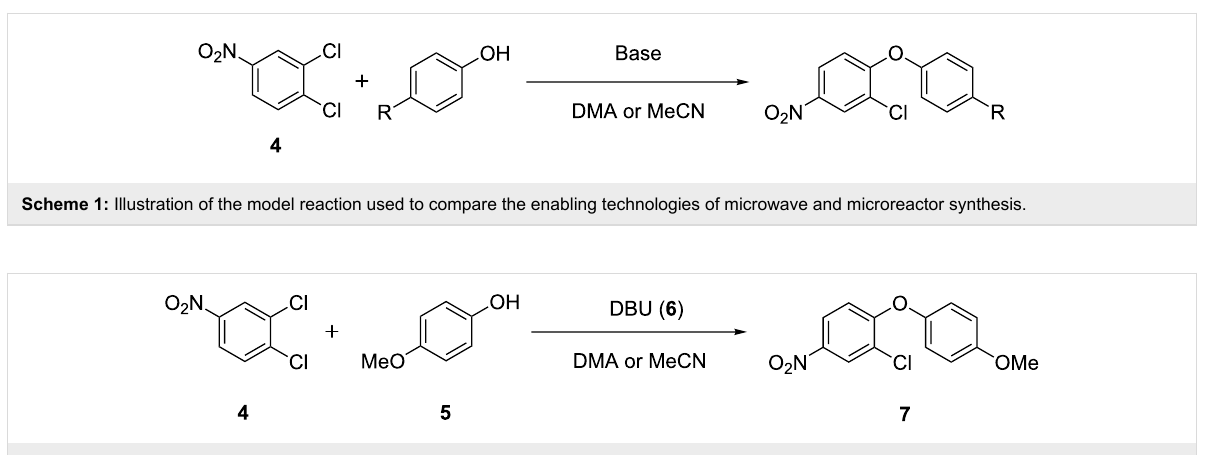
Scheme 2: Illustration of the model reaction used to benchmark Labtrix S1 against batch and stopped-flow microwave reactors.